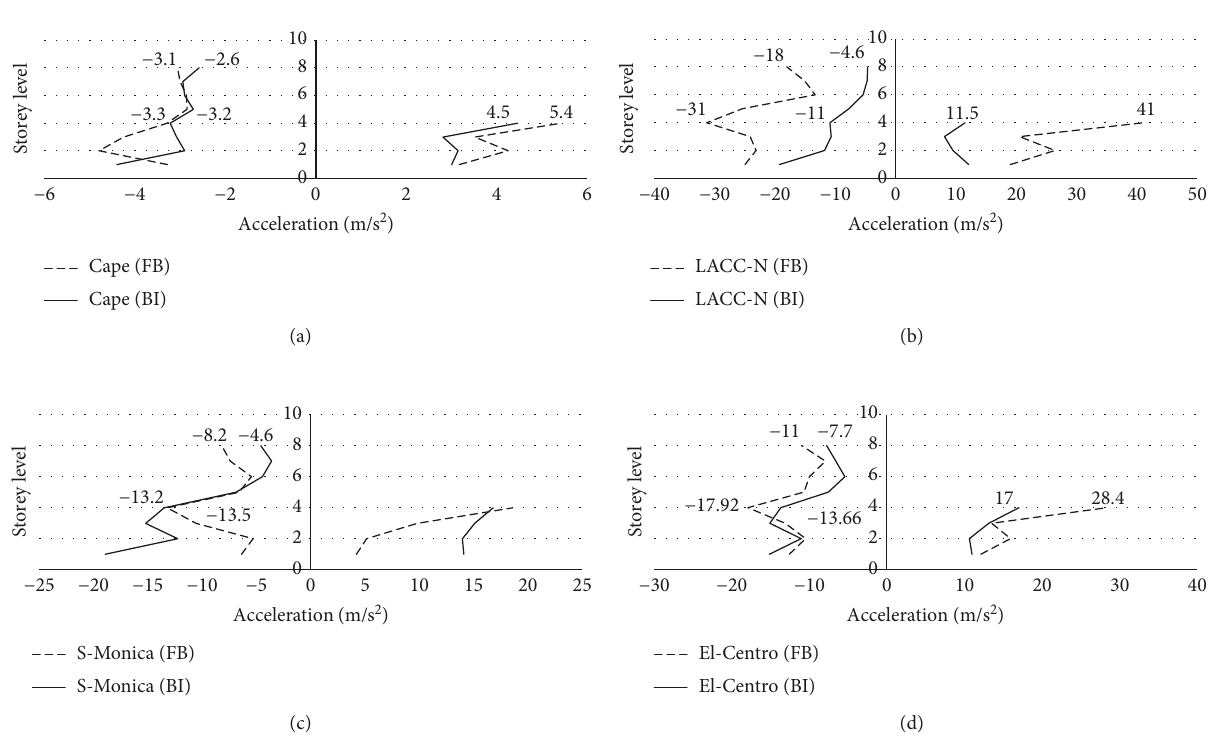
Figure 12: Maximum accelerations of the floor levels of the adjacent buildings under the earthquakes. (a) Cape. (b) LACC-N. (c) S-Monica. (d) El-Centro. Table 5: Acceleration response of the shorter FFB and FBI buildings under considered motions. FFB taller building acc. (m/s 2 Earthquake